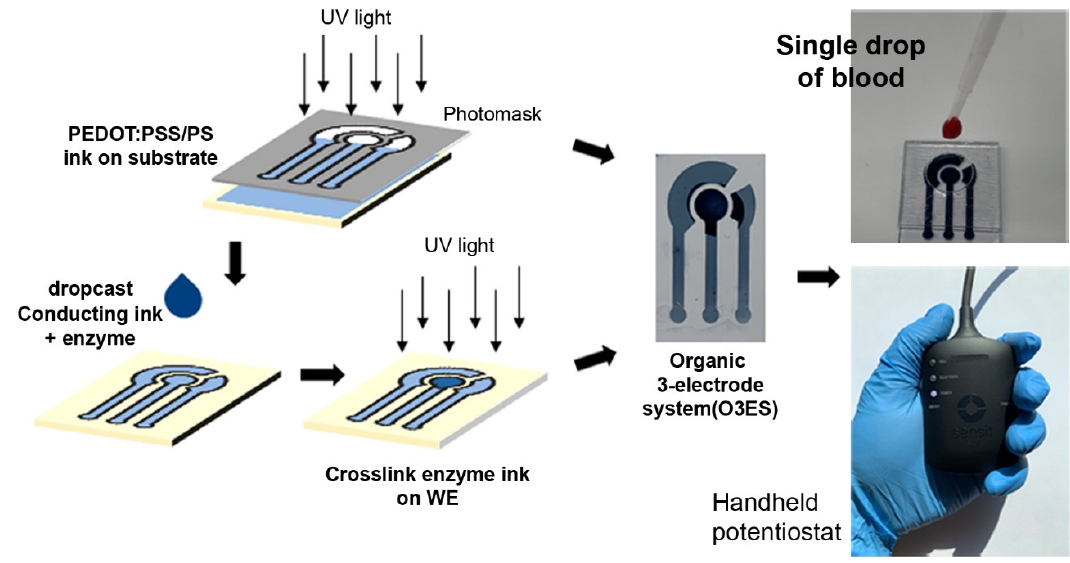
Figure 1. Schematic of fabrication of the organic 3-electrode sensors (O3ES) and testing of single drop of blood via a handheld, wireless enabled device.